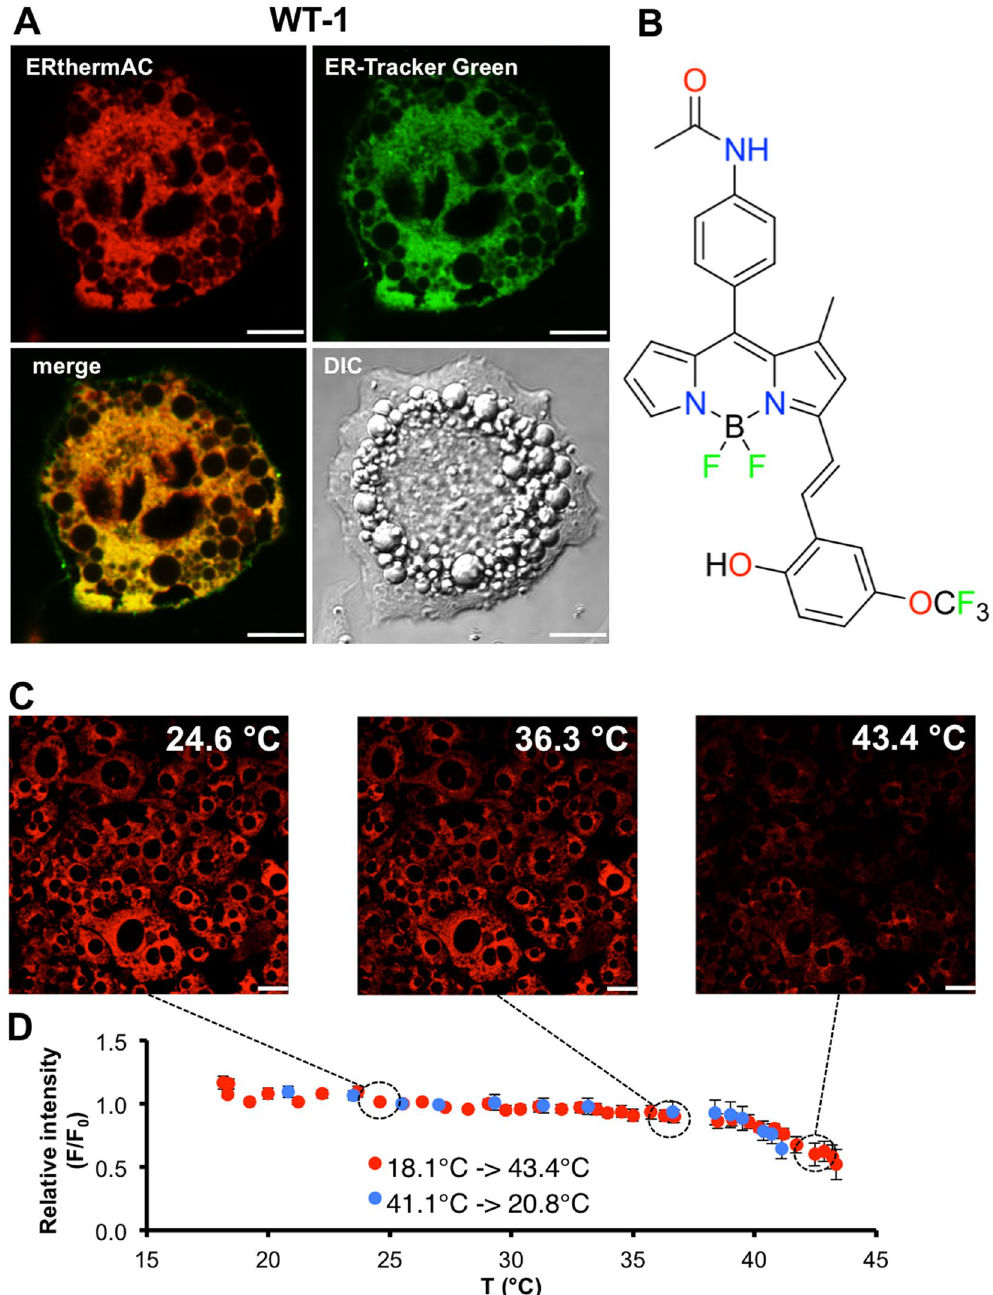
Figure 1. ERthermAC targets the endoplasmic reticulum in adipocytes, and its intensity is inversely proportional to temperature. ( A ) ERthermAC (red) co-localises with ER-Tracker Green (green) in WT-1 cells, as evident from the yellow mix colour after superimposition of signals. Scale bar: 10 μ m. ( B ) Chemical structure of ERthermAC. ( C ) Differentiated WT-1 cells were stained with ERthermAC, fixed with 4% formaldehyde, and imaged at different temperatures ranging between 18 °C and 43 °C. At higher temperatures, cells display lower ERthermAC fluorescence intensity. Scale bar: 20 μ m. ( D ) Calibration curve shows a reversible non-linear relationship between temperature and fluorescence intensity of ERthermAC in fixed WT-1 cells between 18 °C and 43 °C. Temperature sensitivities determined by the linear fit were − 1.07%/°C (R 2 = 0.76, n = 15 cells) between 18.1 °C and 35.0 °C, and − 4.76%/°C (R 2 = 0.83, n = 15 cells) between 37 °C and 43